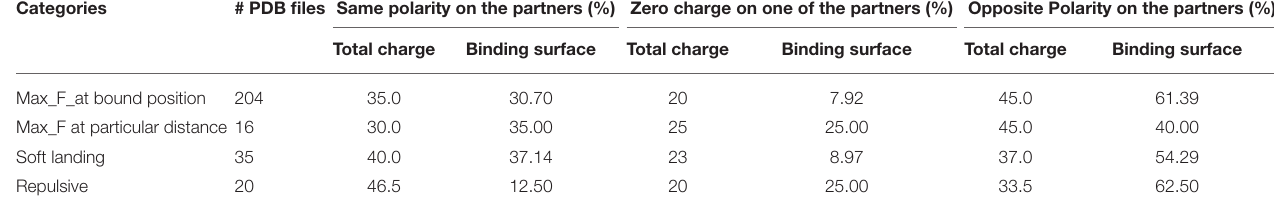
TABLE 1 | The percentage of the polarity of net and interfacial charges of partners for each protein complexes.